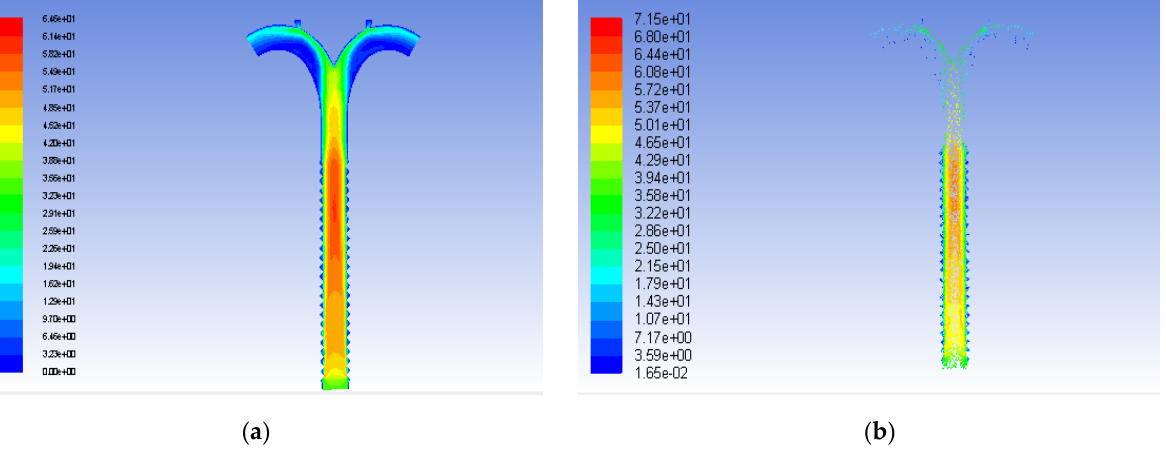
Figure 8. Distributor air flow analysis diagram. ( a ) Airflow velocity and flow field distribution; ( b ) Airflow velocity vector.